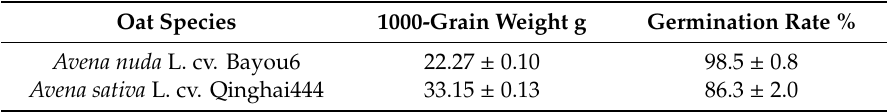
Table 2. Seed characteristics of the two oat